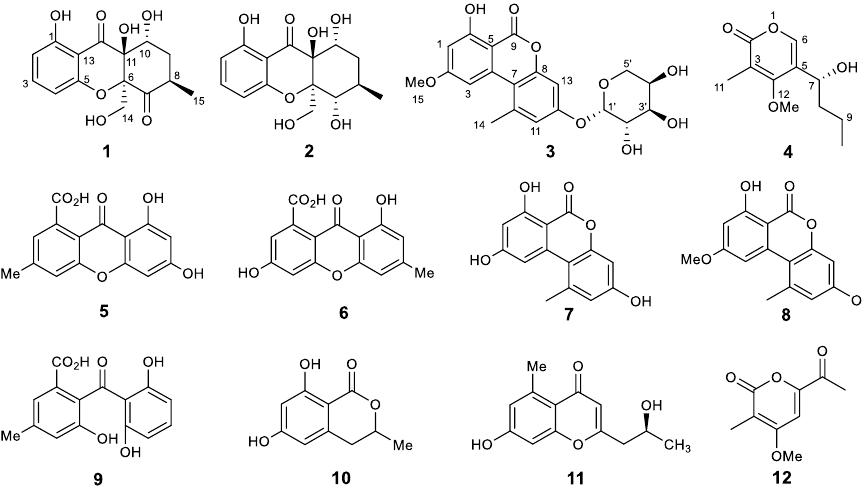
Figure 1. Structures of isolated compounds ( 1 – 12 ).